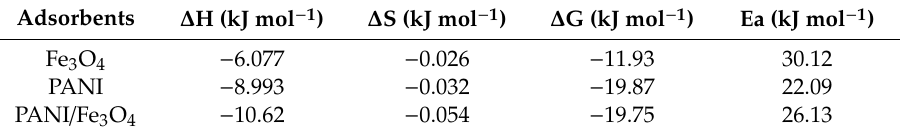
Table 5. Activation energy and thermodynamic parameters of AB40 adsorption.